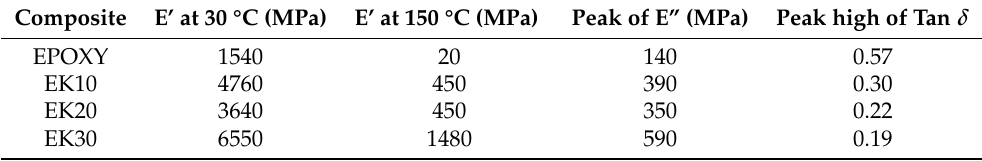
Table 2. Results of DMA analysis of the